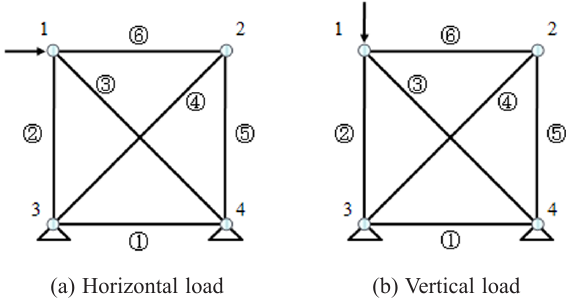
Fig. 5. Planar truss under different loading